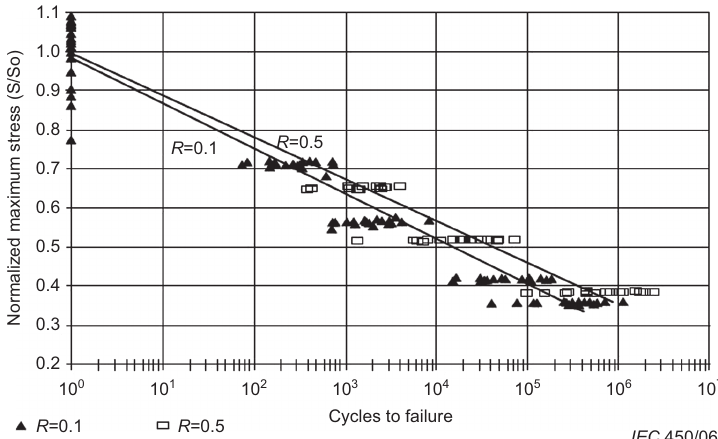
Figure 14 S-N diagram for composite materials of spar [10].